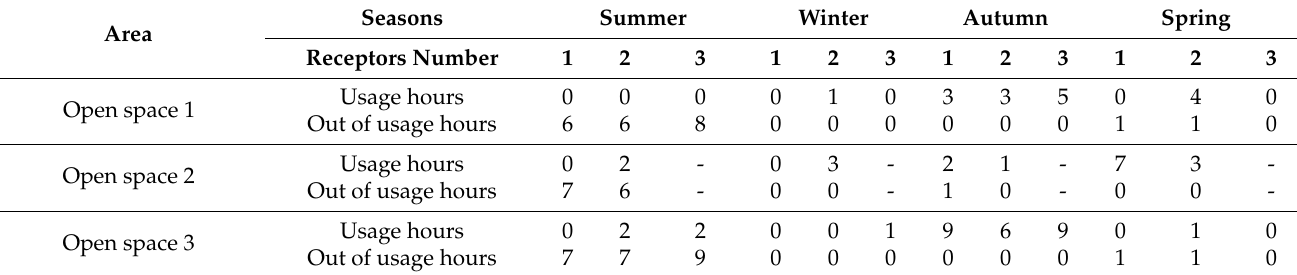
Table 6. Summary of thermal comfort duration for usage hours (08:00–17:00) and out-of-usage hours for all open spaces.